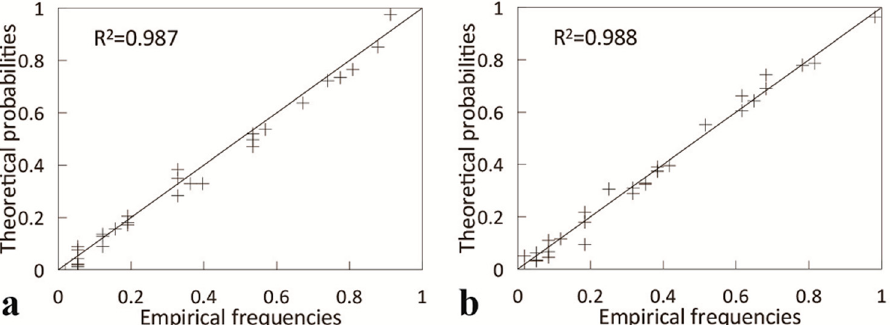
Figure 8. Correlation between empirical frequencies and theoretical probabilities for flood occurrence dates and magnitudes. ( a ) Flood occurrence dates. ( b ) Flood magnitudes.